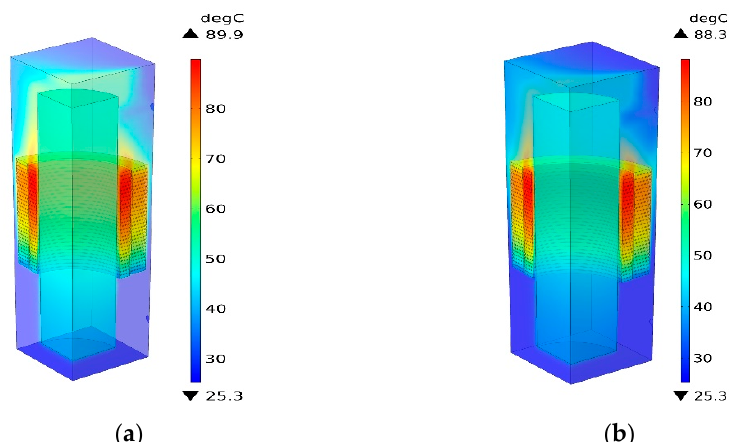
Figure 11. Temperature distribution of silicon steel transformer and amorphous alloy motor trans- former. ( a ) Temperature field of silicon steel transformer; ( b ) Temperature field of amorphous alloy transformer.